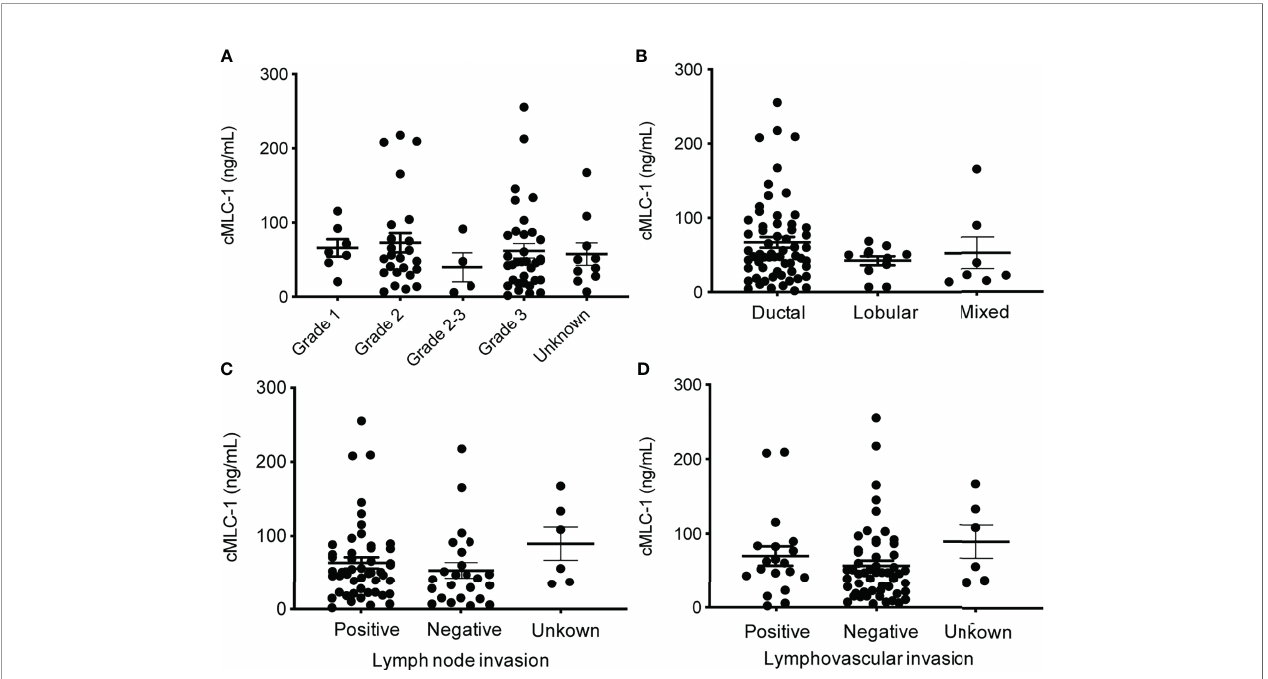
FIGURE 5 | Plasma cMCL-1 levels in breast cancer patient sub-cohorts divided by various clinicopathological features. The means ± SD of plasma cMLC-1 levels in groups of histology grade [Grade 1 (n=7), Grade 2 (n=24), Grade 2-3 (n=4), Grade 3 (n=34), unknown (n=10)] ( p =0.8233) (A) ; in ductal (n=61), lobular (n=11), and mixed histology characters (n=7) ( p = 0.3169) (B) are shown. The means ± SD of cMLC-1 levels in patients with lymph node (+) (n=49), lymph node ( – ) (n=24), unknown (n=6) ( p =0.3163) (C) ; and in patients with lymphovascular invasion (+) (n=19), without ( – ) (n=54), unknown (n=6) ( p =0.2730) (D) are shown. The one-way ANOVA was used to test differences among all indicated multiple